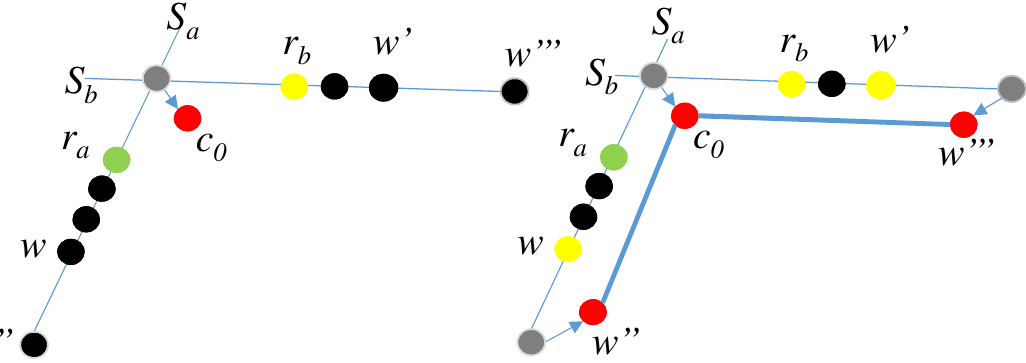
Figure 10. An illustration of how a corner c 0 of P moves during Stage